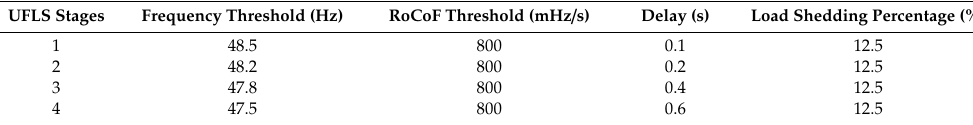
Table 1. Load-shedding scheme characteristics in El Hierro isolated power system.